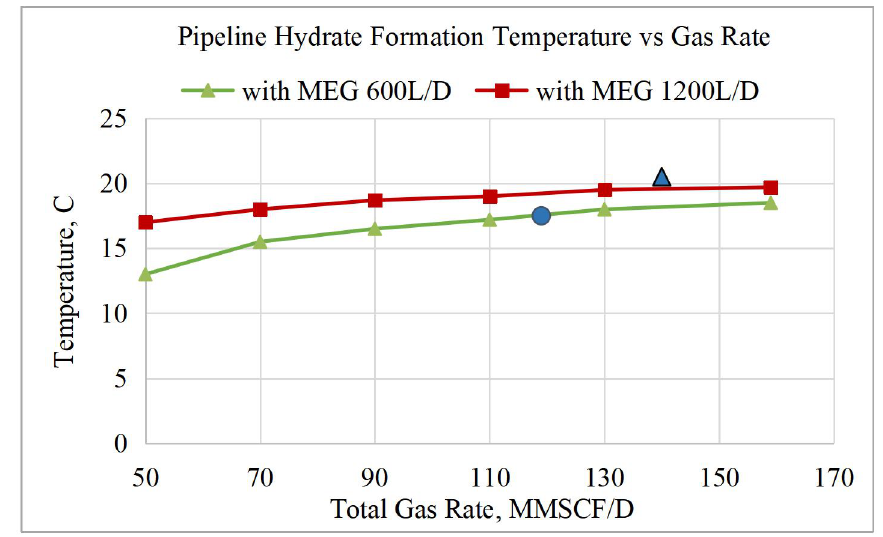
Figure 12—Sour gas hydrate formation temperature at pipeline inlet at a given pressure & various MEG